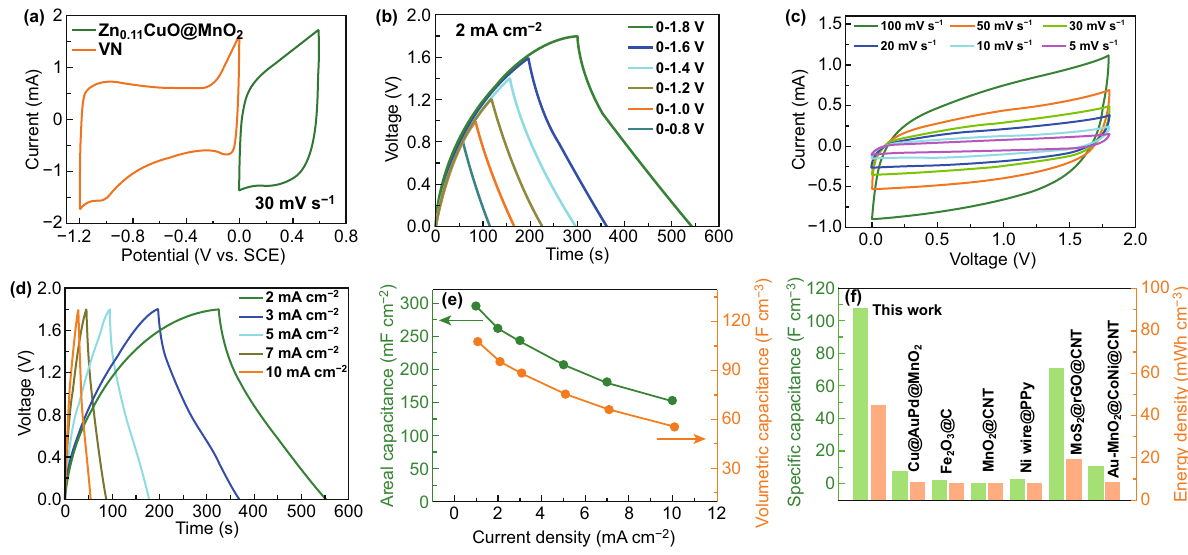
Fig. 5 a Comparison of CV curves of the Zn 0.11 CuO@MnO 2 positive electrode and VN@CNT film negative electrode. b GCD curves of ACFSC device collected over different voltages from 0.8 to 1.8 V at a current density of 2 mA cm −2 . c CV curves of ACFSC device at various scan rates. d GCD curves of ACFSC device at different current densities. e Comparison of areal and volumetric specific capacitance curves of ACFSC device calculated from the charge–discharge curves as a function of the current density. f Areal specific capacitances and energy densi‑ ties of our device in comparison with previously reported